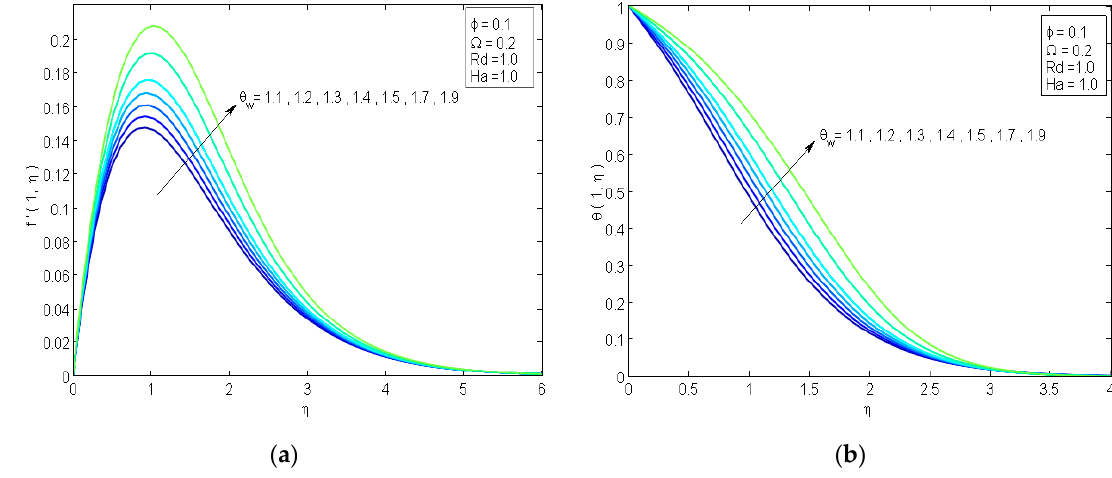
Figure 7. The effectiveness of θ w on velocity field ( a ) and on temperature field ( b ).